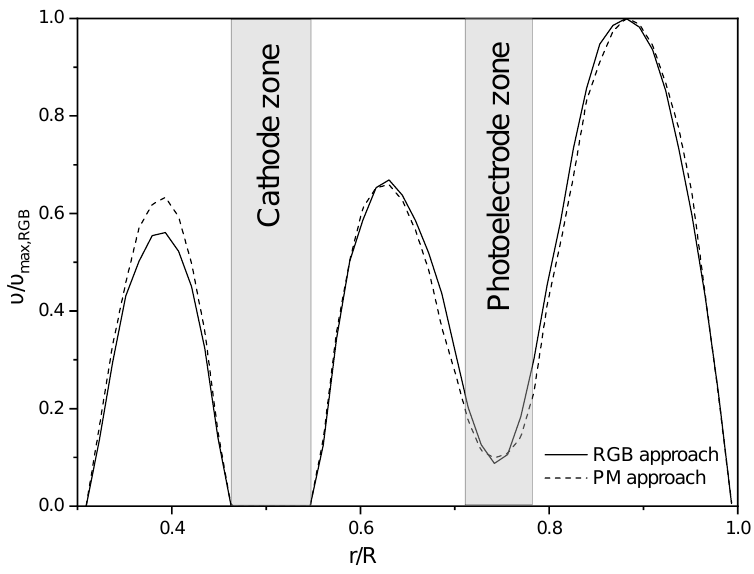
Figure 15. Fully developed velocity magnitude profile using the RGB and PM approach.